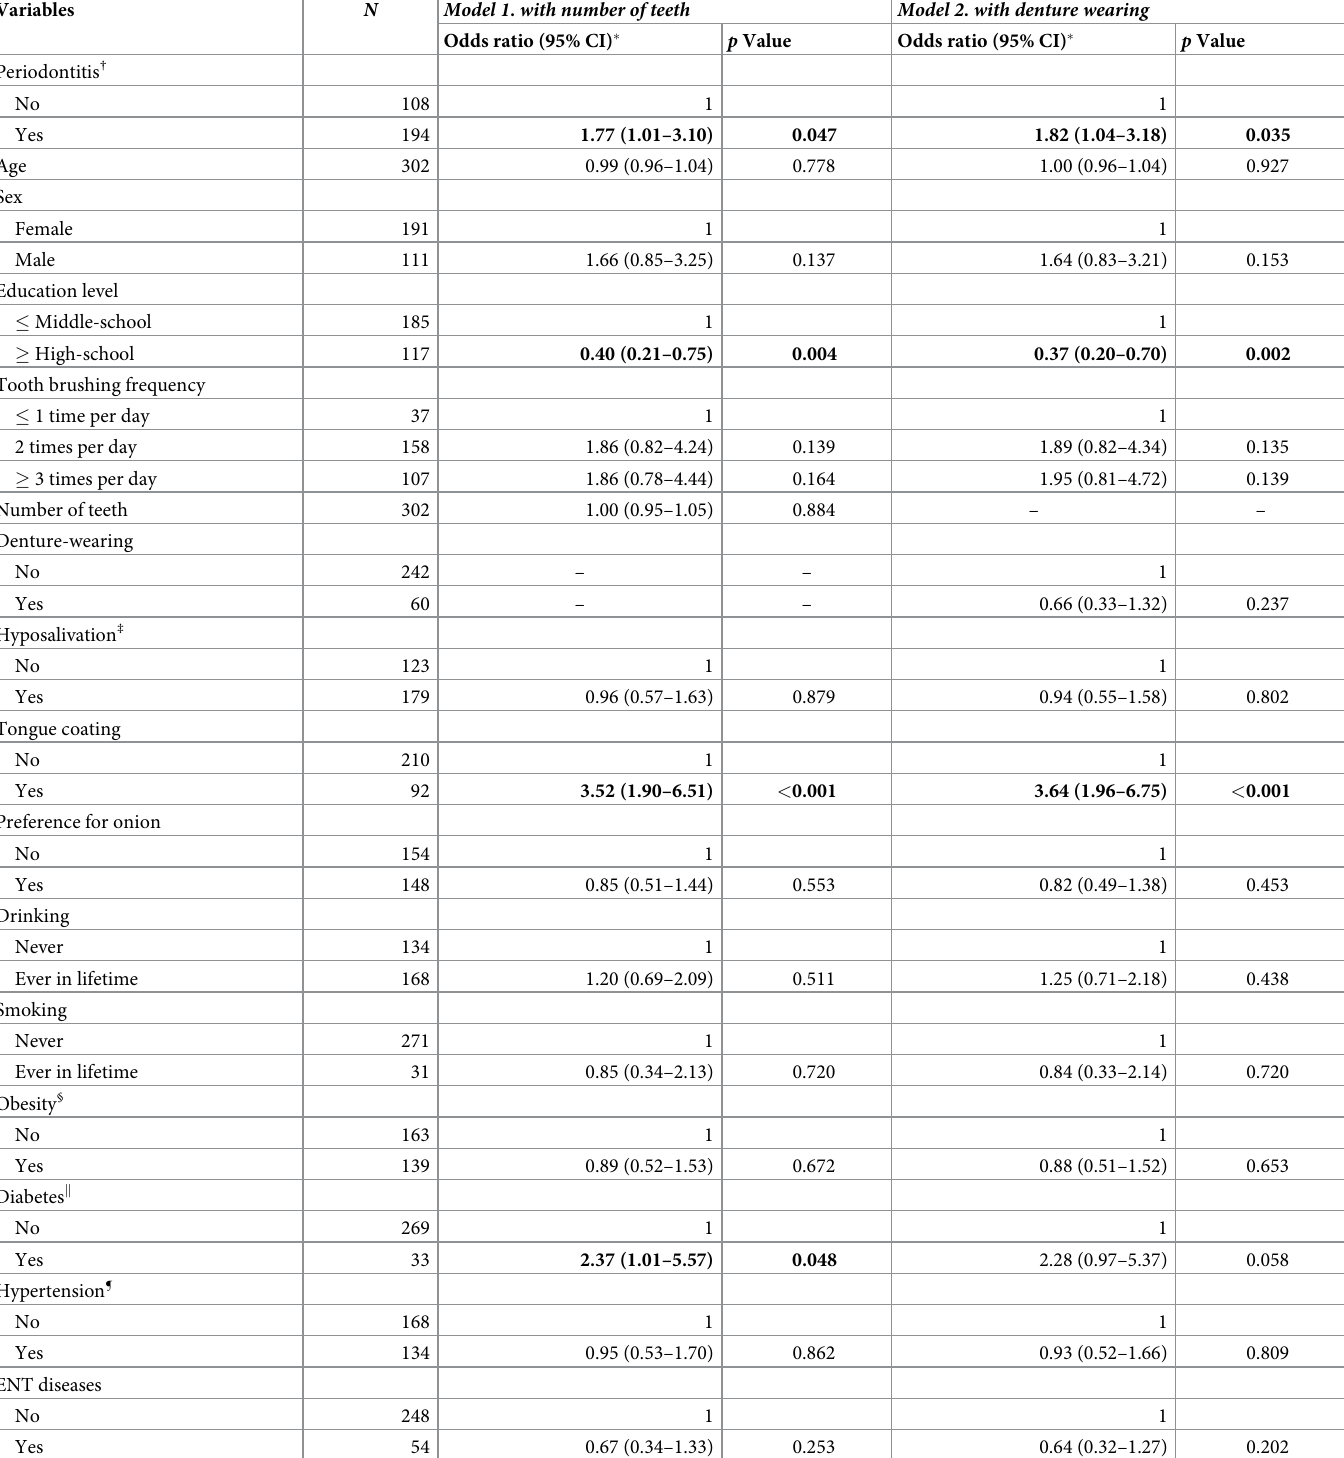
Table 3. Adjusted association of periodontitis with oral malodor (OLS � 2) in association sample ( n =